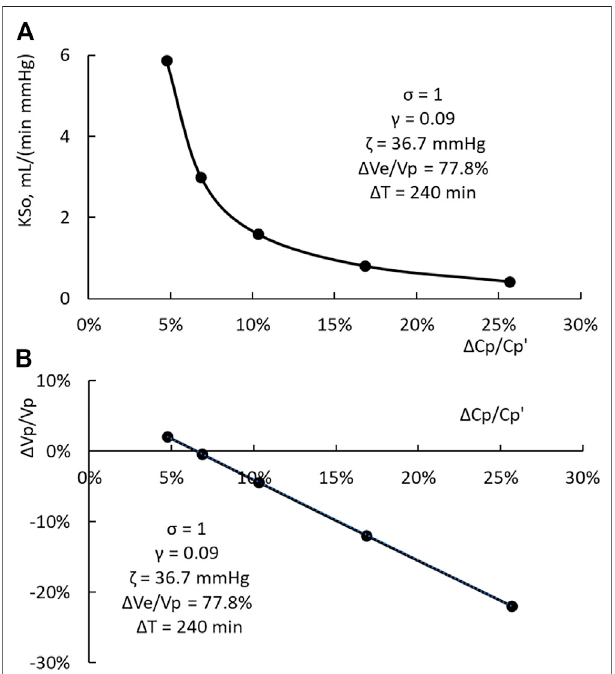
FIGURE 5 | (A) One-to-one relation between KSo and the PPC increment Δ Cp/Cp ’ . (B) One-to-one relation between the relative change in plasma volume Δ Vp/Vp and the PPC increment.